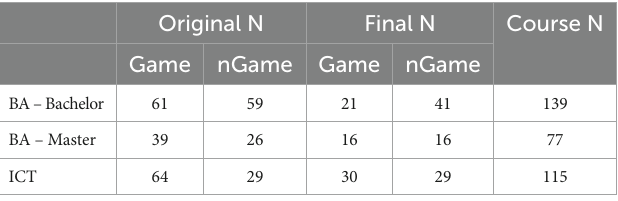
TABLE 1 Distribution of